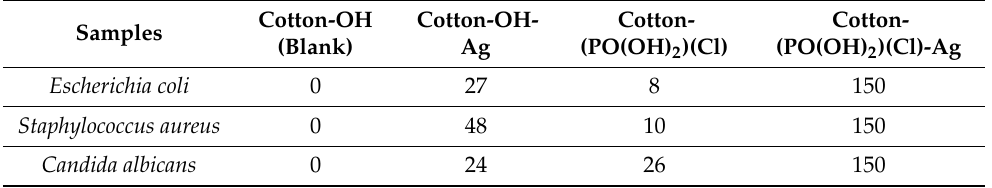
Table 2. The inhibition of bacterial growth by samples. Cotton-OH Cotton-OH- Cotton- Cotton- Samples (Blank) Ag (PO(OH) 2 )(Cl) (PO(OH) 2 )(Cl)-Ag Escherichia coli 0 27 150 Staphylococcus aureus 0 48 150 Candida